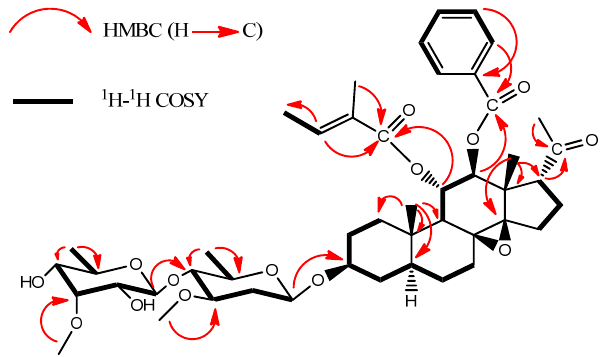
Figure 2. Key HMBC and 1H-1H COSY correlations of 1 .